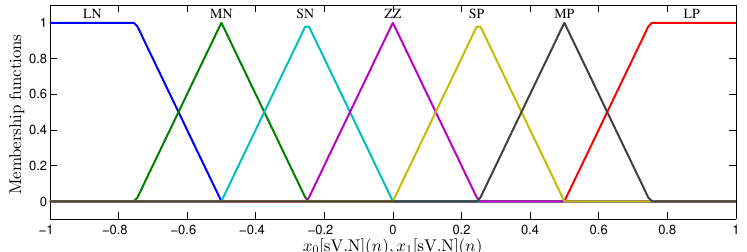
Figure 7. Membership functions from inputs x 0 [ sV.N ]( n ) and x 1 [ sV.N ]( n )